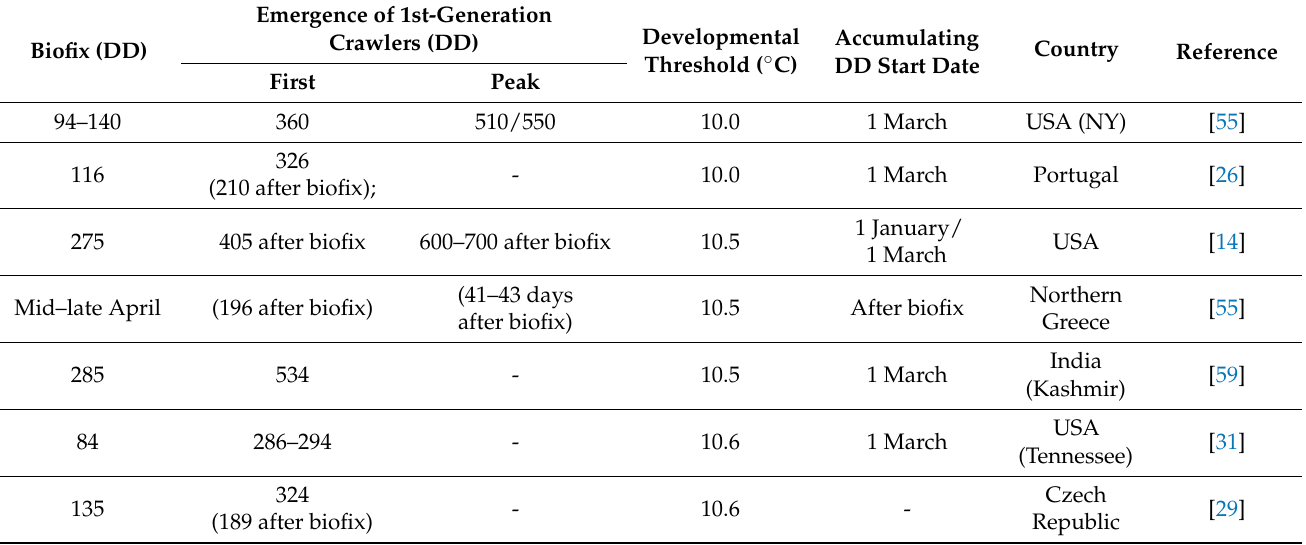
Table 1. Timing of San Jos é scale 1st-generation events based on degree-day